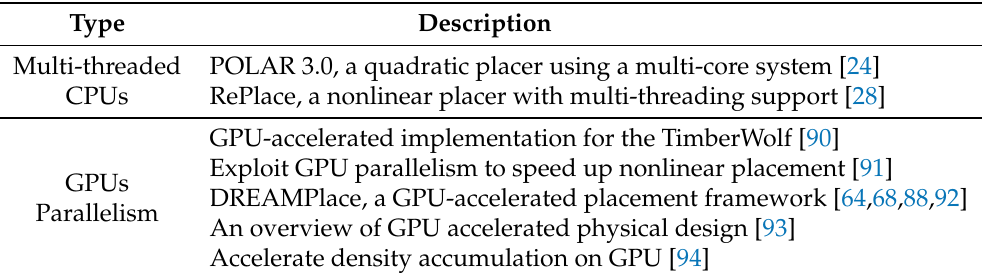
Figure 7. Comparison of CPU and GPU architectures. The orange, blue, green, and milk-white rectangles represent the control unit, computing unit, cache, and memory. Table 4. Related research on multi-threaded CPUs and GPUs accelerating VLSI